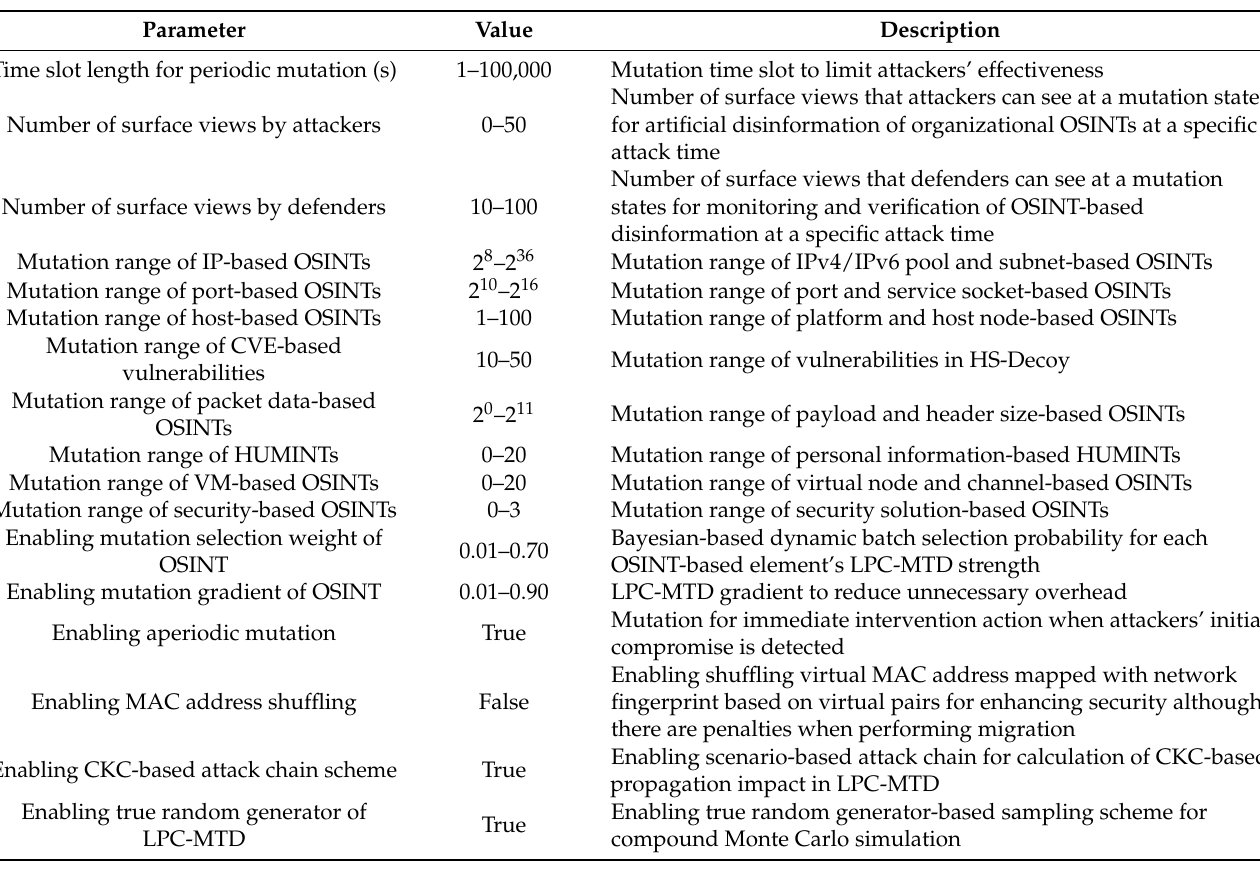
Table A2. Examples of deceptive parameters of LPC-MTD.